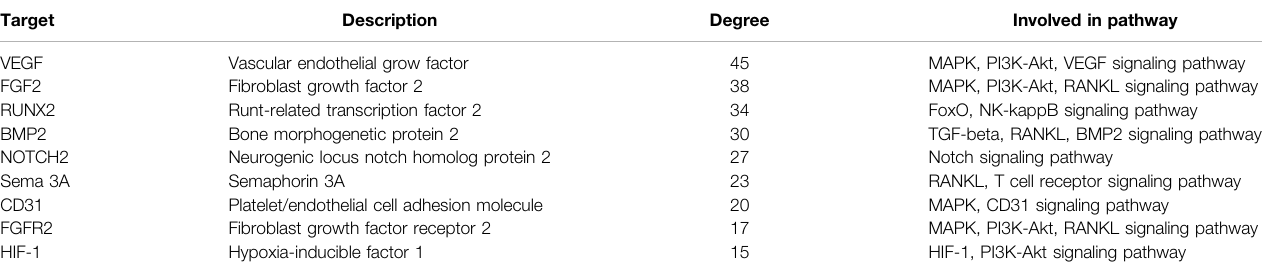
TABLE 3 | The core targets and their network degrees and related